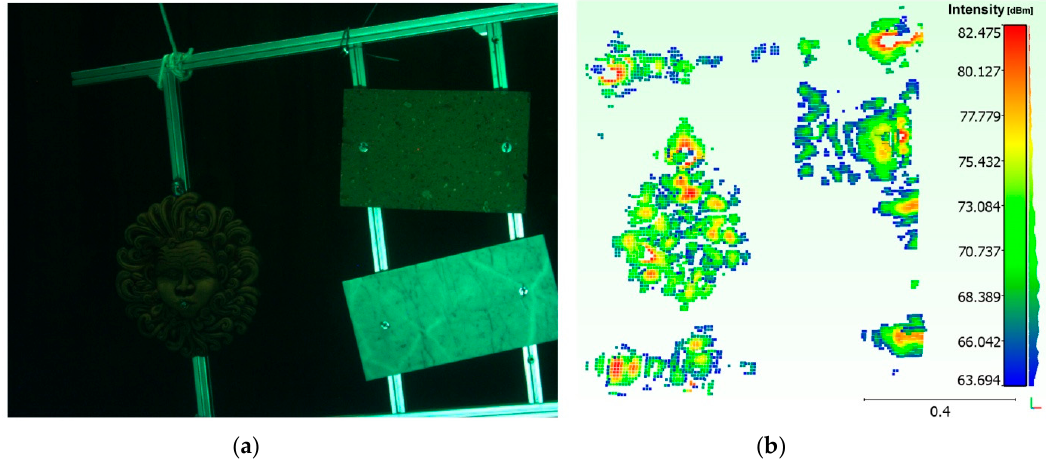
Figure 8. Target acquisition with objects: ( a ) optical; ( b ) acoustic.